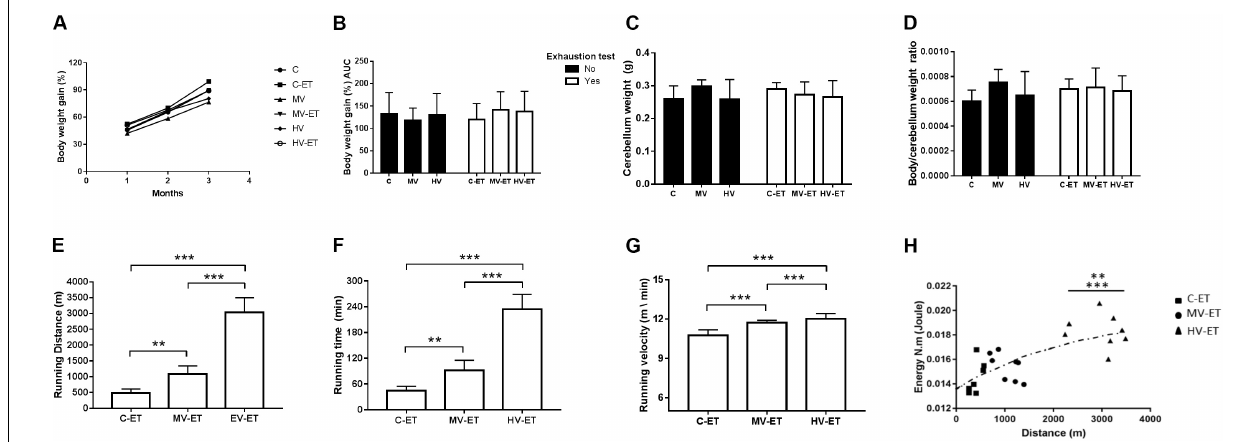
FIGURE 2 | Somatic parameters and Running performance. (A) Body weight gain during months of training. (B) Area under the curve of body weight gain. (C) Cerebellum weight; (D) Body weight/cerebellum weight ratio. (E) Running distance of exhaustion test: MV-ET vs. C-ET; P = 0.002. HV-ET vs. MV-ET; C-ET; P < 0.001; (F) Running time of exhaustion test: MV-ET vs. C-ET; P = 0.002. HV-ET vs. MV-ET; C-ET; P < 0.001. (G) Velocity of exhaustion test HV-ET vs. MV-ET; C-ET; P < 0.001. (H) Horizontal Workload vs. running time during exhaustion test HV-ET vs. MV-ET ( P = 0.002); C-ET; P < 0.001. C-ET, control + exhaustion test group; MV, moderate-volume group; MV-ET, moderate-volume + exhaustion test group; HV, high-volume group; HV-ET, high-volume + exhaustion test group. ** P < 0.01; *** P < 0.001. Values represent mean ± S.D.